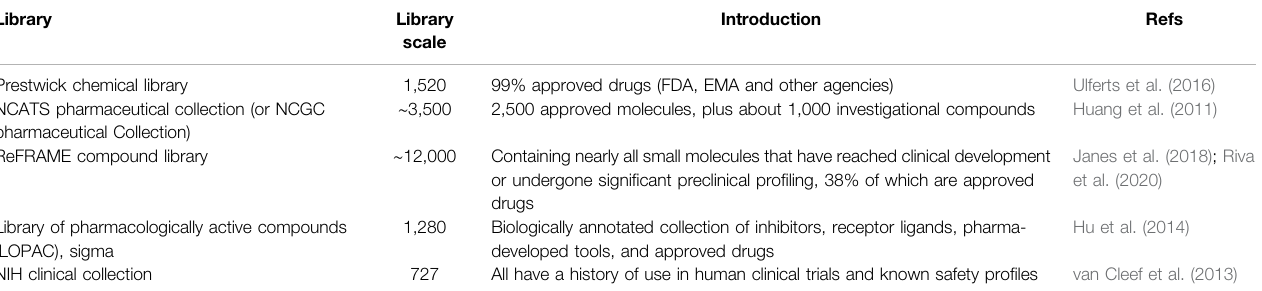
TABLE 2 | Compound library for drug